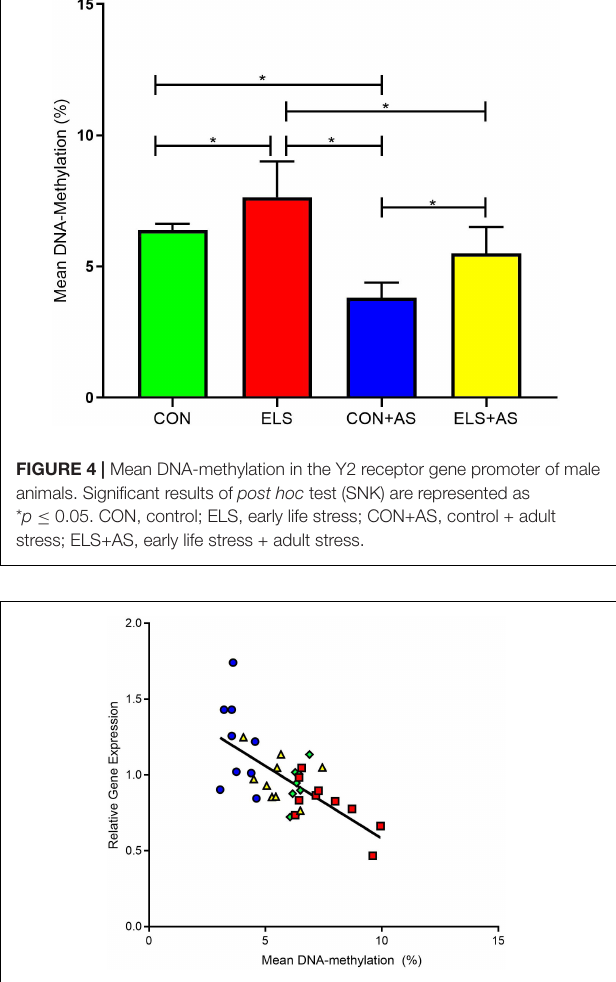
FIGURE 5 | Correlation analysis between Y2 receptor gene expression and mean DNA-methylation overall male experimental groups. We found that Y2 gene expression was negatively correlated to mean DNA-methylation. CON, control; ELS, early life stress; CON+AS, control + adult stress; ELS+AS, early life stress + adult